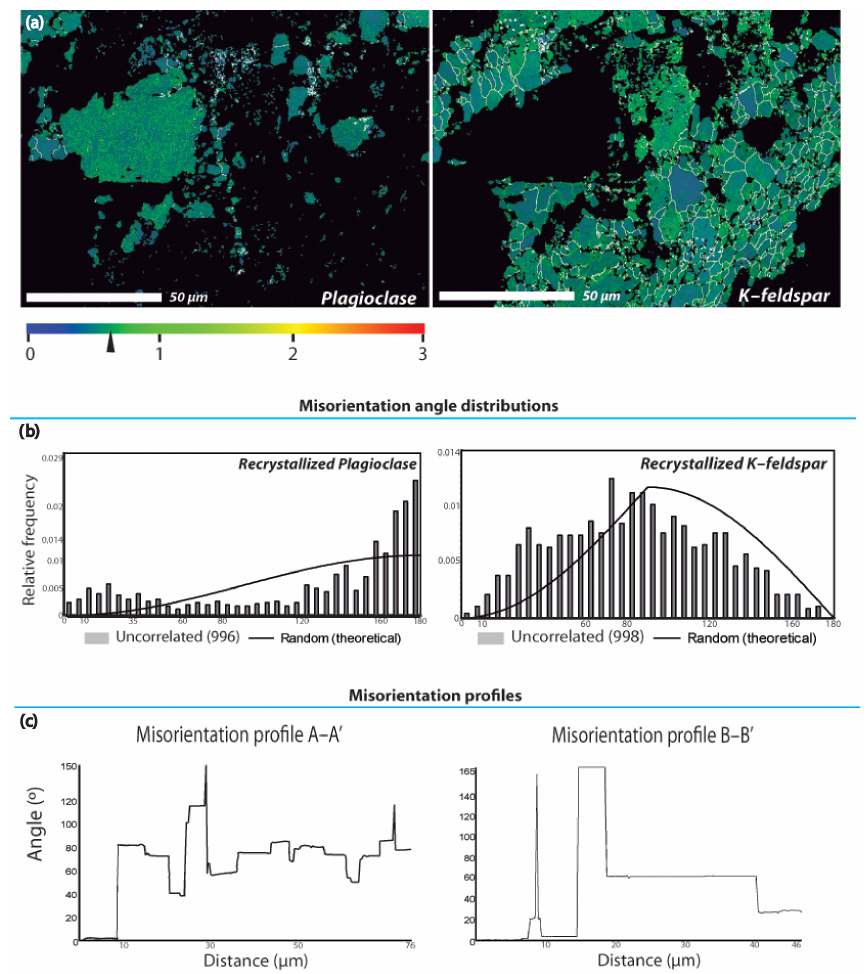
Figure 11. (a) Local misorientation maps of plagioclase and K-feldspar. The maps show the degree of misorientation of each pixel with respect to the neighbouring pixels in a radius of 3 × 3 pixels. A threshold of 3 ◦ was used, so that the maps only image the locations of misorientations that are less than 3 ◦ . The colour scale shows the degree of misorientation on a scale of 0 to 3 ◦ , and the arrow indicates the average misorientation. Low-angle boundaries >3 ◦ are outlined in white. (b) Misorientation angle distribution of fine-grained plagioclase and K-feldspars (porphyroclasts larger than 15µm are not considered). (c) Misorientation profiles for fine-grained K-feldspar (profile A-A’ in Fig. 10) and plagioclase (profile B-B’ in Fig. 10) grains. See text for